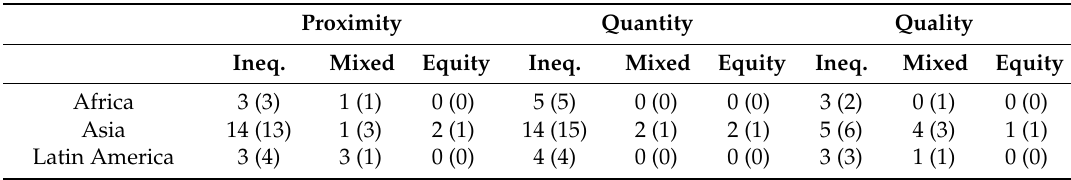
Table 7. Cross-tabs for green space inequalities broken down by continent. Proximity Quantity Quality Ineq. Mixed Equity Ineq. Mixed Equity Ineq. Mixed Equity Africa 3 (3) 1 (1) 0 (0) 5 (5) 0 (0) 0 (0) 3 (2) 0 (1) 0 (0) Asia 14 (13) 1 (3) 2 (1) 14 (15) 2 (1) 2 (1) 5 (6) 4 (3) 1 (1) Latin America 3 (4) 3 (1) 0 (0) 4 (4) 0 (0) 0 (0) 3 (3) 1 (1) 0